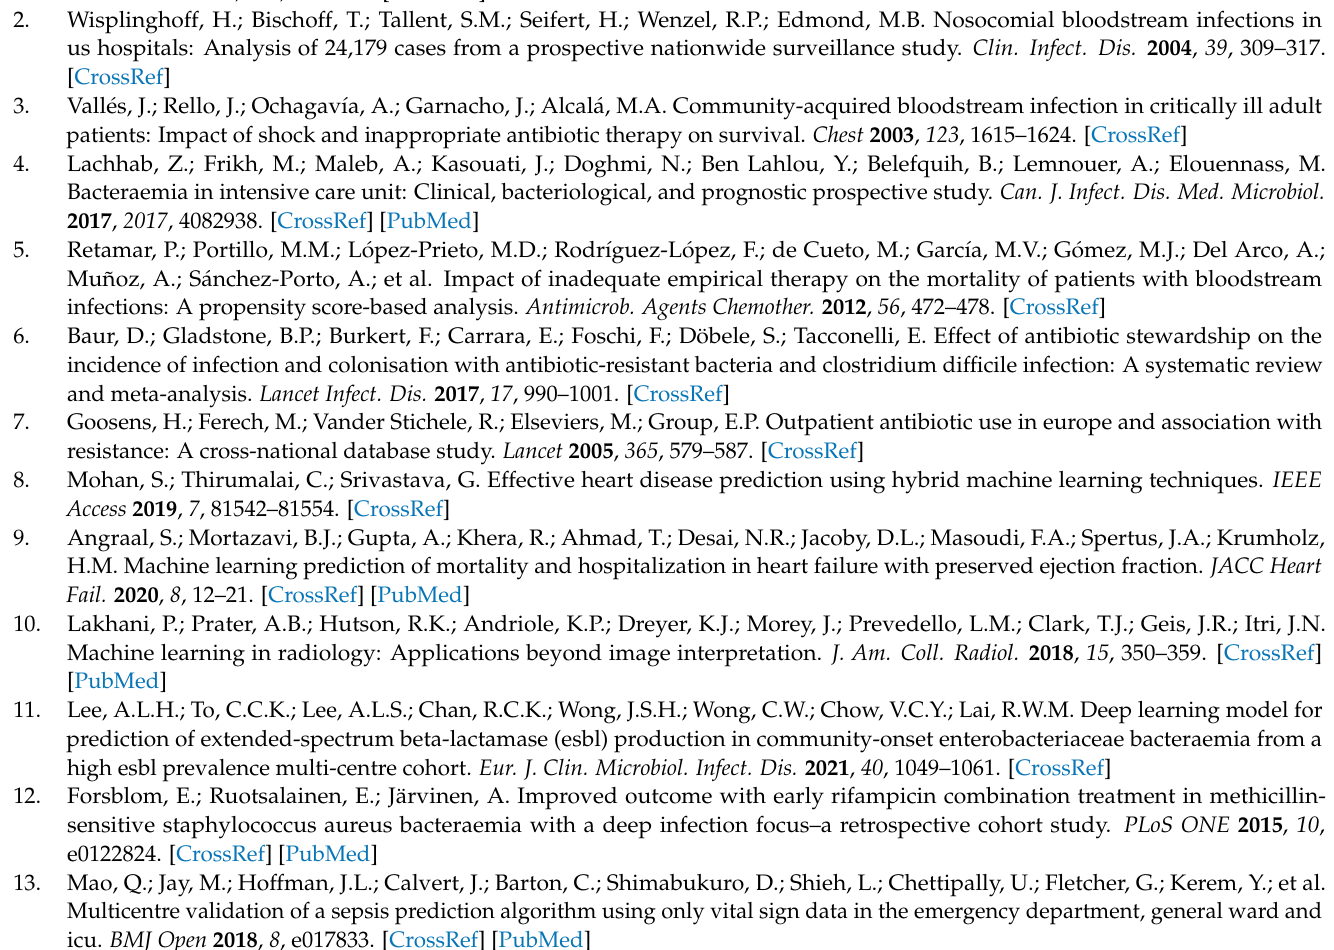
Table S2: Baseline characteristics between bacteremia and non-bacteremia groups using clinical data from 12 h before blood culture